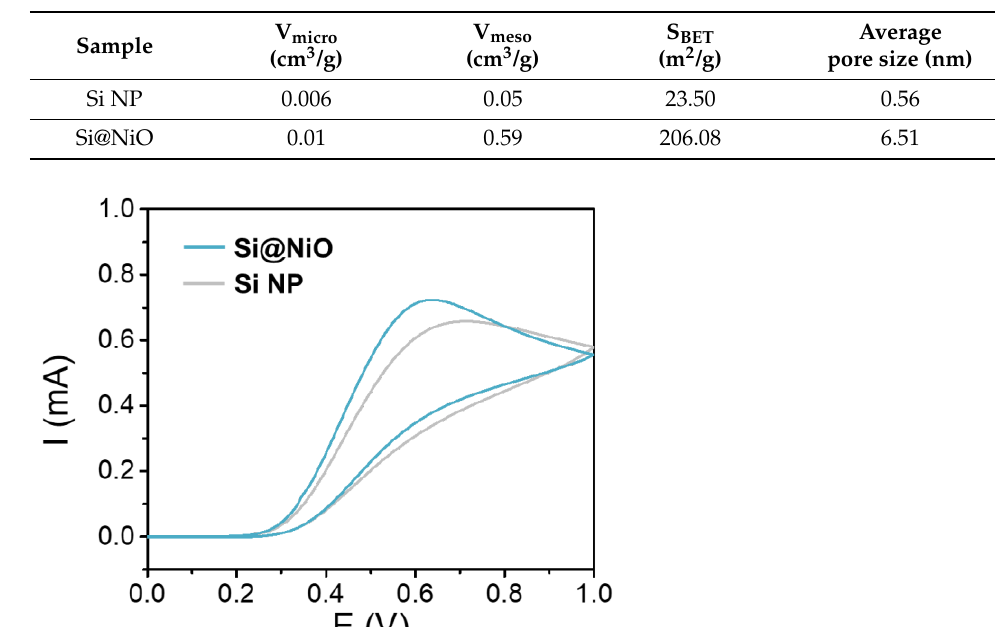
Figure 3. Pore structure characterization of Si@NiO nanoflowers. ( A ) N 2 adsorption–desorption isotherms and ( B ) pore size distribution of Si NPs and Si@NiO based on the BJH method. Table 1. Micro pore volume (V micro ), mesopore volume (V meso ), specific surface area (S BET ), and average pore size of Si and Si@NiO.